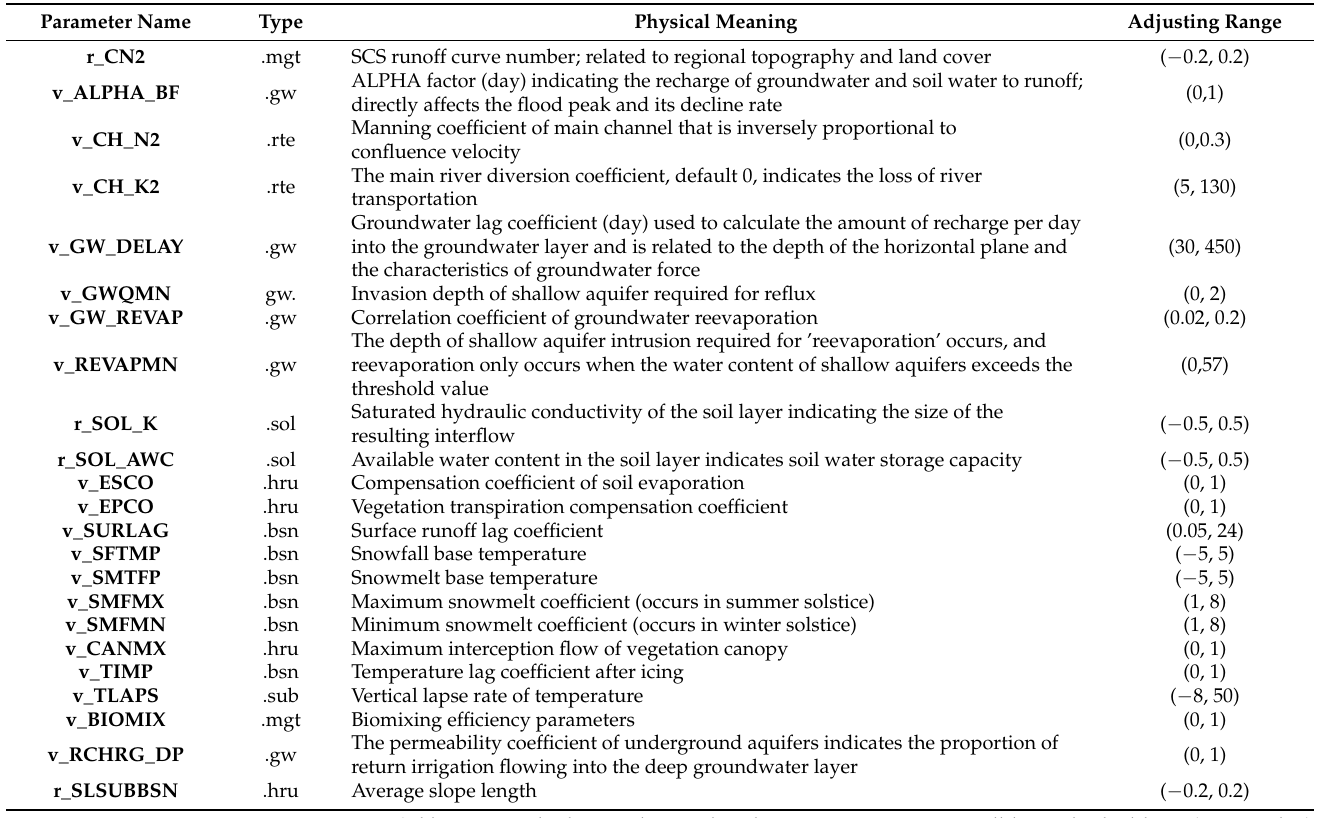
Table 4. Selected parameters in the preliminary calibration of the SWAT